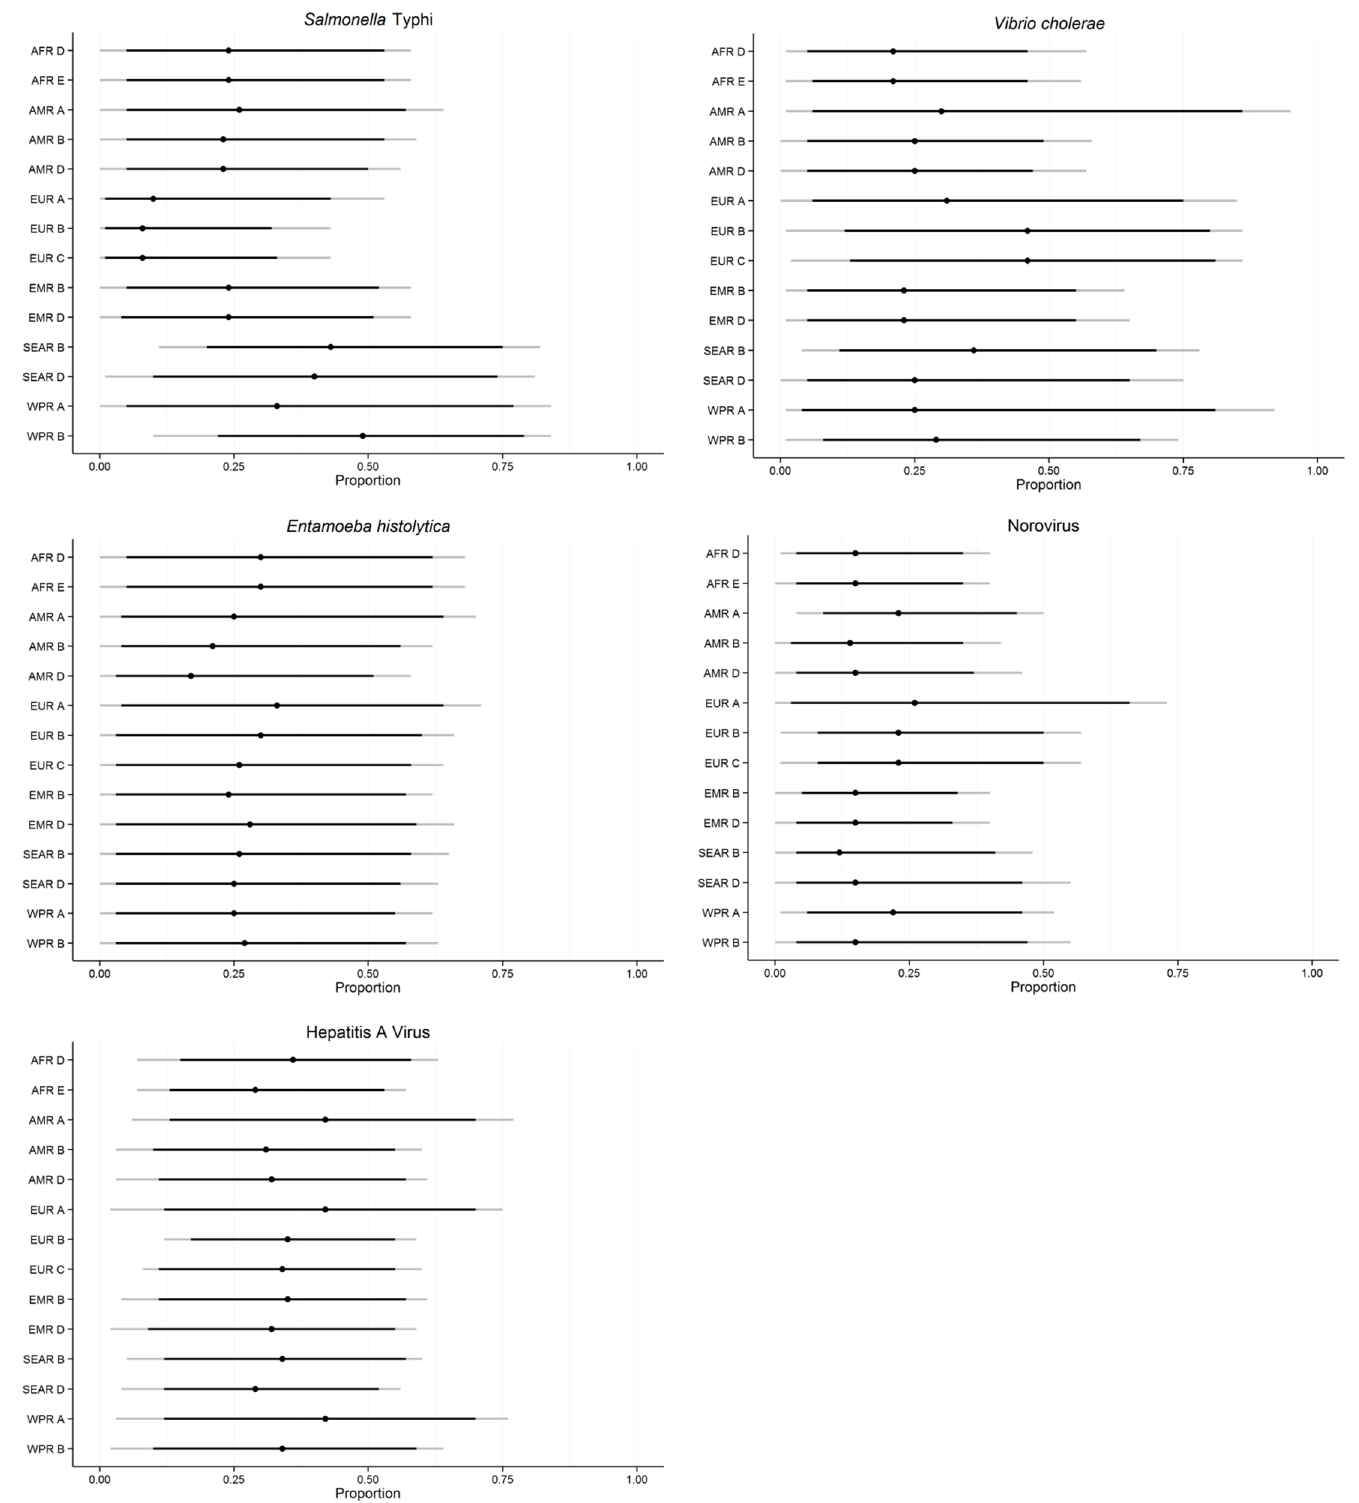
Fig 5. Subregional estimates of the proportion of foodborne illnesses caused by Salmonella Typhi, Vibrio cholerae , Entamoeba histolytica , Norovirus, and Hepatitis A virus. Indicated on the line plot are the 2.5 th , 5 th , 50 th , 95 th and 97,5 th percentiles.